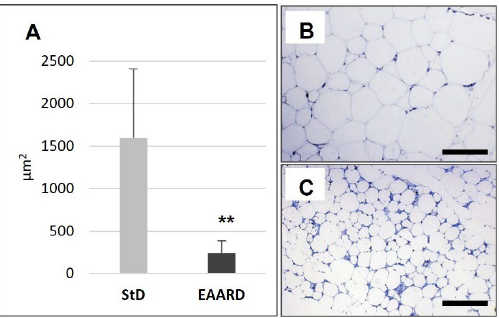
Figure 2. ( A ): Mean (±sd) rpWAT adipocyte area ( t = 9.559, p = 0.000) according to diet. ** p < 0.01. ( B , C ): Representative images of semithin rpWAT sections toluidine blue stained from StD and EAARD, respectively. Note the dramatic size reduction in lipid droplets in EAARD mice. Original magnification 100×; scale bar 50 μm.